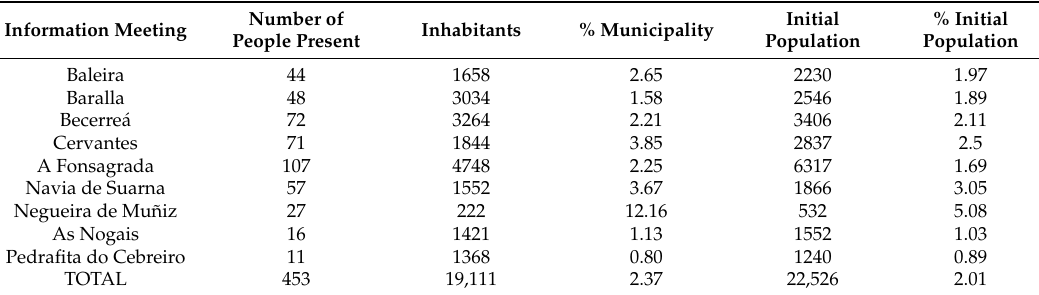
Table 4. Attendance at information meetings.